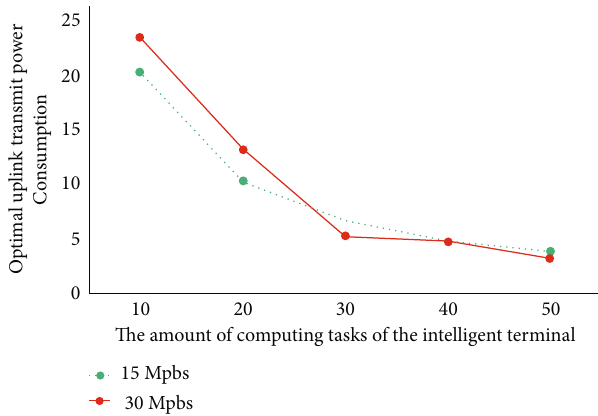
Figure 4: Optimal uplink transmission power